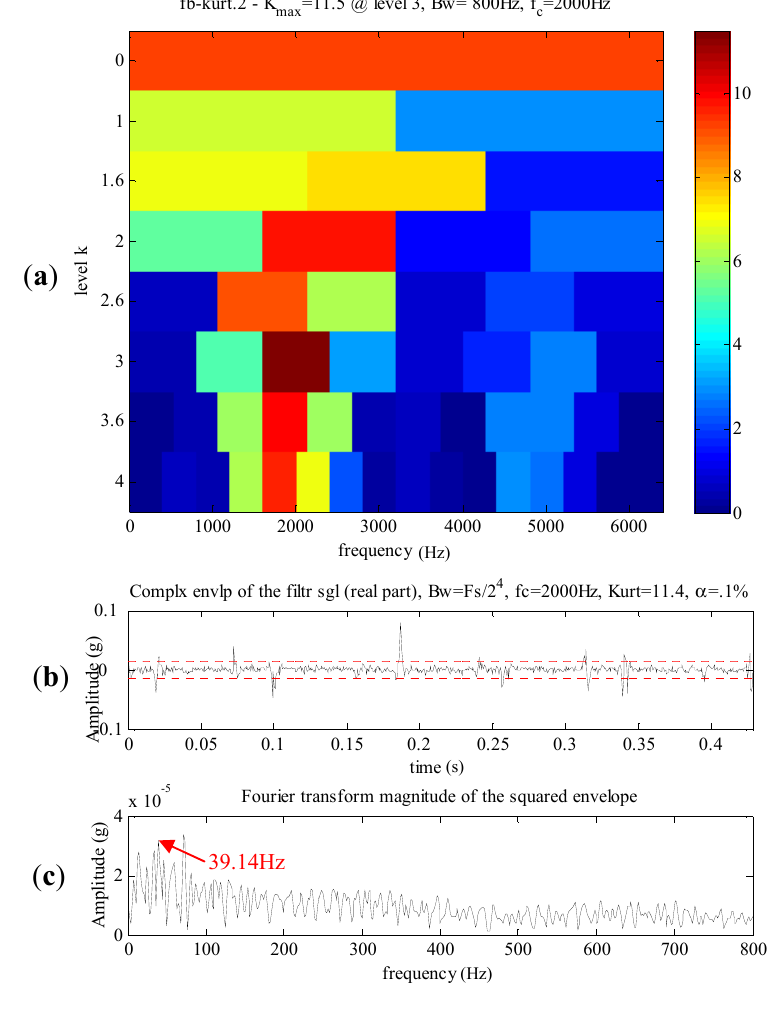
Figure 18. The analyzed results of the defective planetary gearbox signal using spectral kurtosis. ( a ) The Kurtogram. ( b ) The purified signal. ( c ) The envelop spectrum (low-frequency